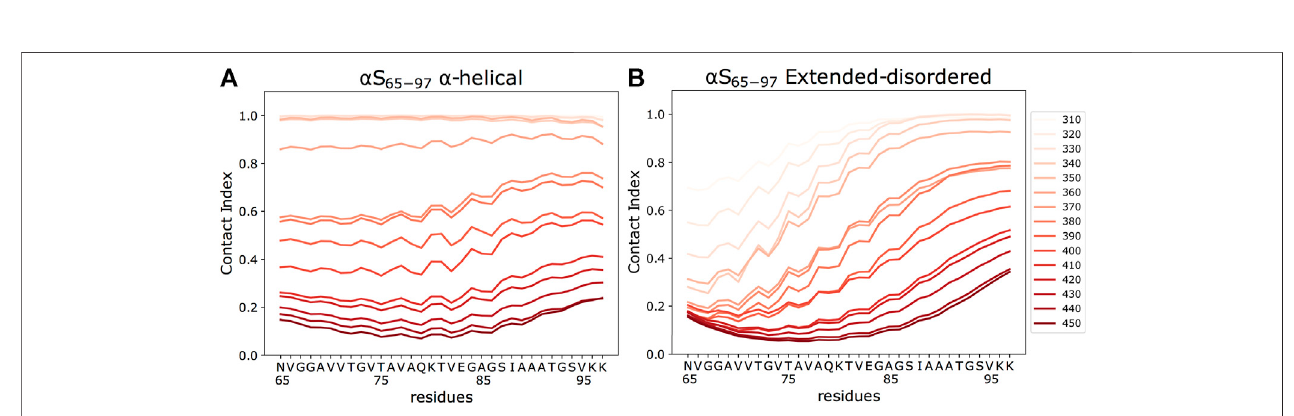
FIGURE 3 | Residue-speci fi c contact indexes. Plots are reported in temperatures ranging from 310 (light red) to 450 K (dark red), with a step increment of 10 K. Contact indexes for α S 65 – 97 were computed for the binding to DOPE:DOPS:DOPC lipid bilayers in helical (A) and extended-disordered (B)